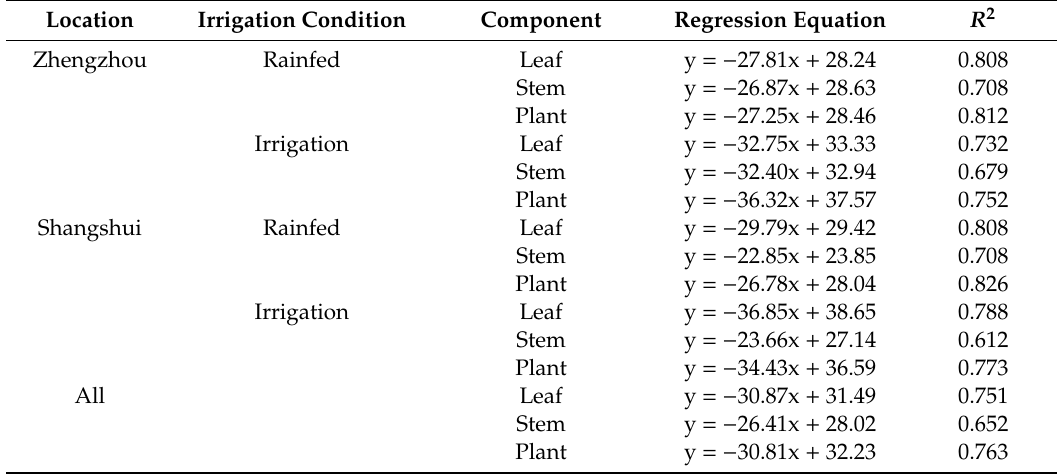
Table 6. Relationship between the NNI and accumulative N deficit in wheat under di ff erent irrigation conditions.